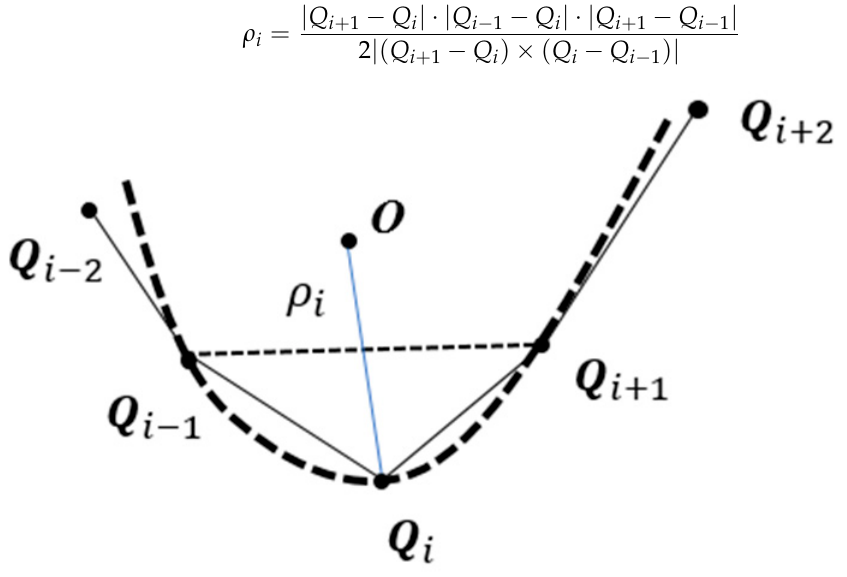
Figure 2. Curvature radius calculation.